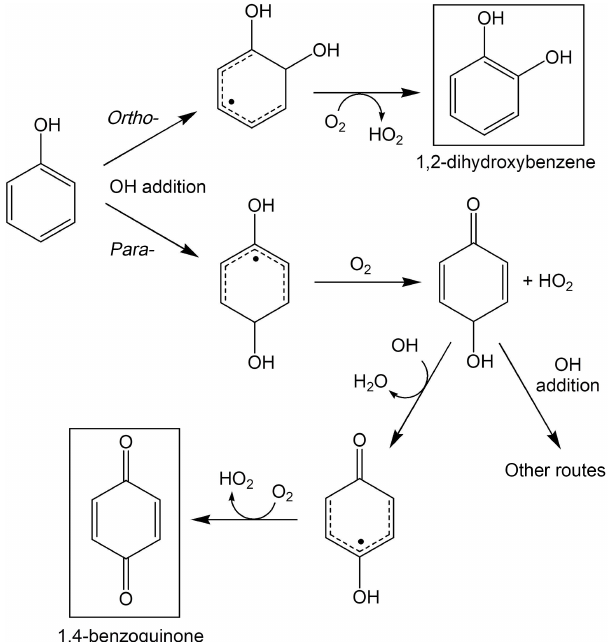
Figure 6. Routes applied following OH addition at an unsubstituted carbon ortho or para to an existing OH substituent in hydroxy- substituted aromatic compounds, using phenol as an example (see Sect.